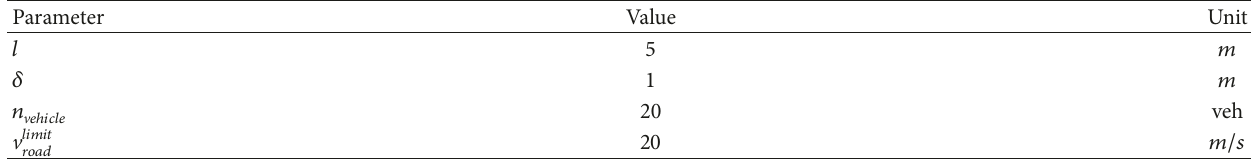
Table 2: Platoon and road information.